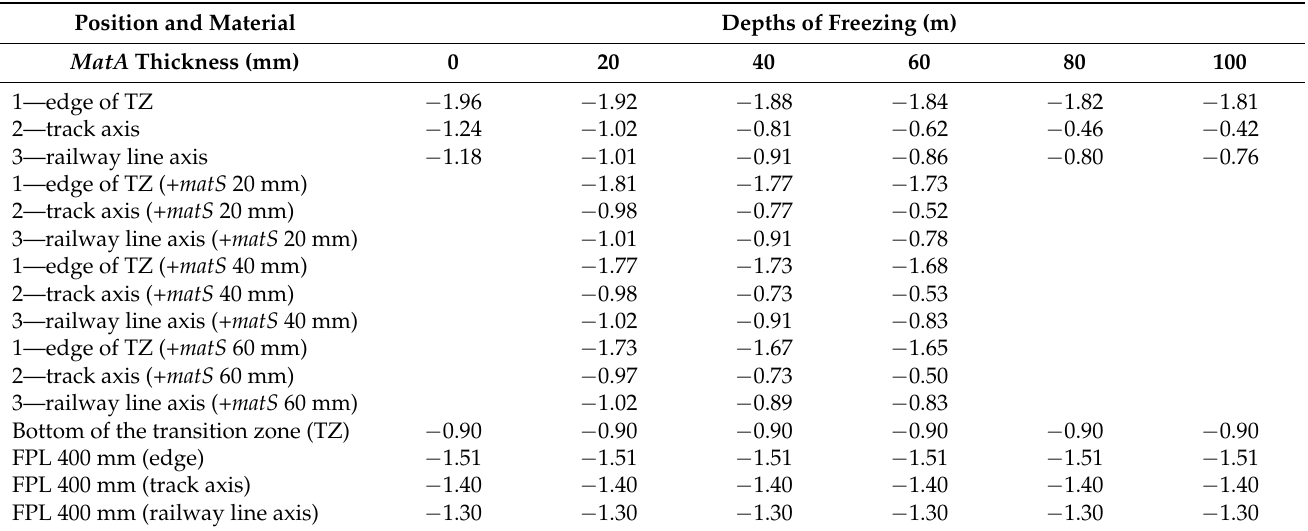
Table 5. Depths of freezing— matA + matS materials: λ = 0.06 W/m · K, thickness 0 to 100 mm.